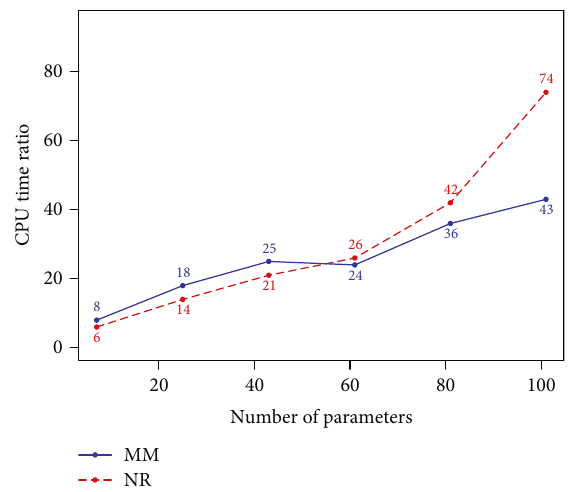
Figure 2: CPU time ratios for NR and MM algorithms ( n = 50 ).